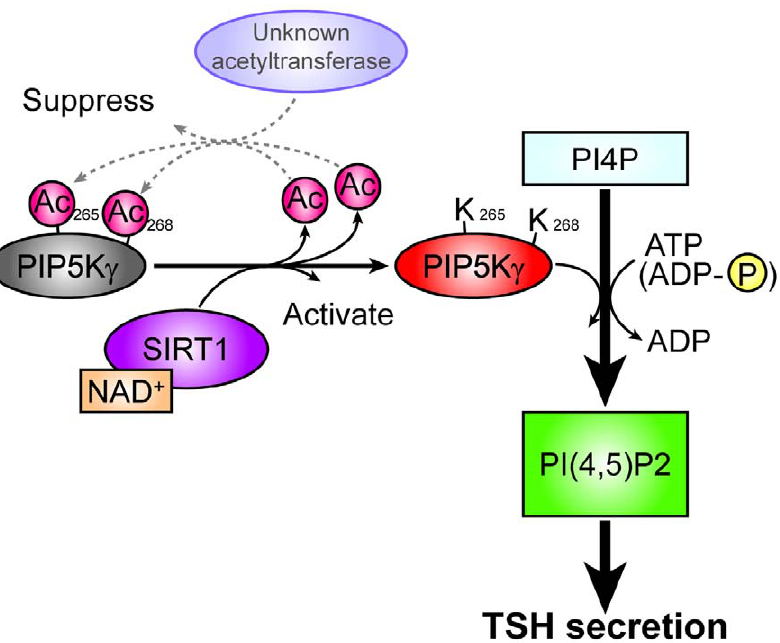
Figure 7. Model for the potential roles of SIRT1 in TSH secretion. Proposed model for regulation of TSH secretion by SIRT1.